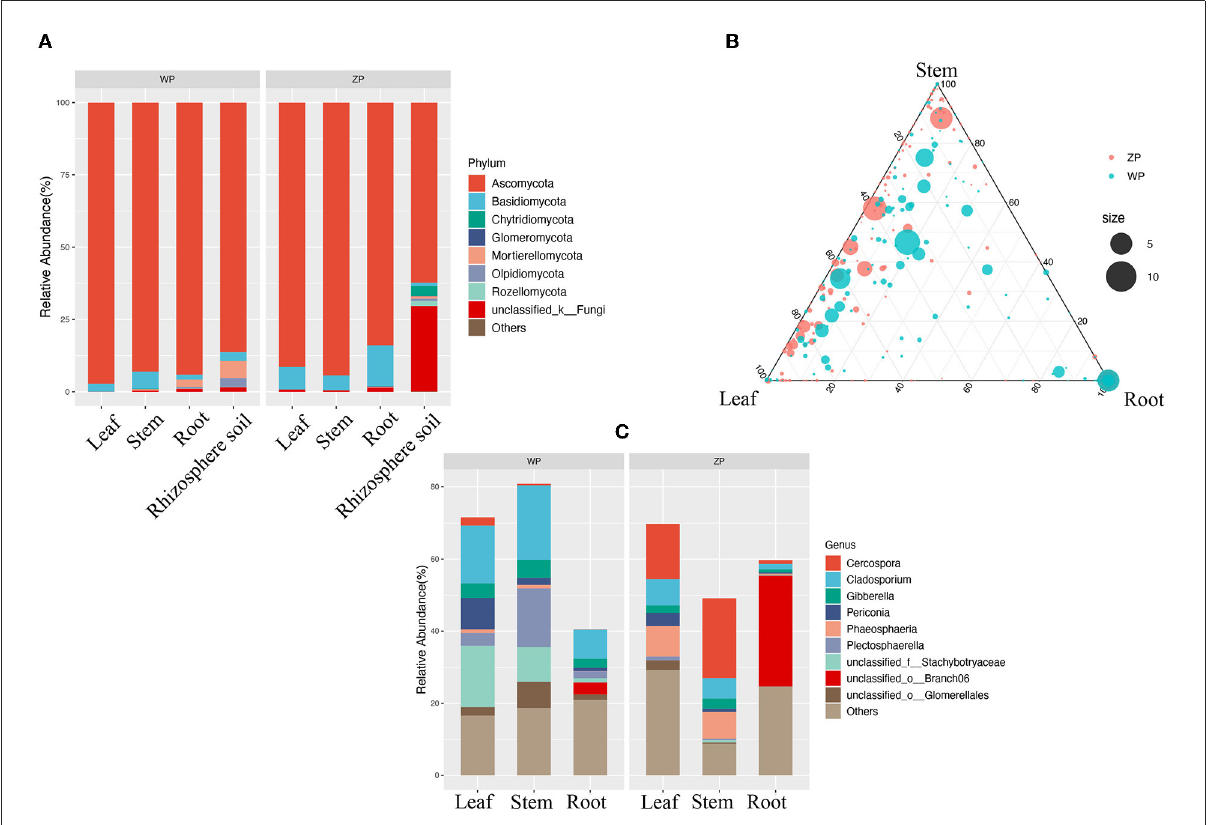
FIGURE4 (A) The community composition of ZP and WP at the phylum level; (B) The ternary phase diagram of community in ZP and WP; (C) The significant differential communities between ZP and